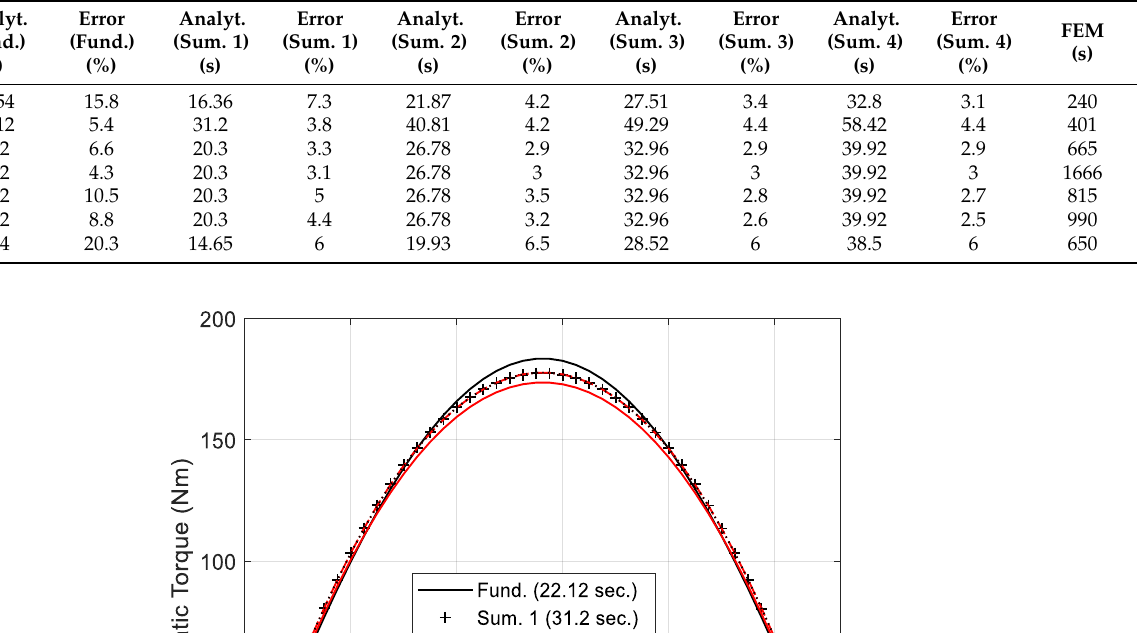
Table 6. Solving time and static torque maximum error.